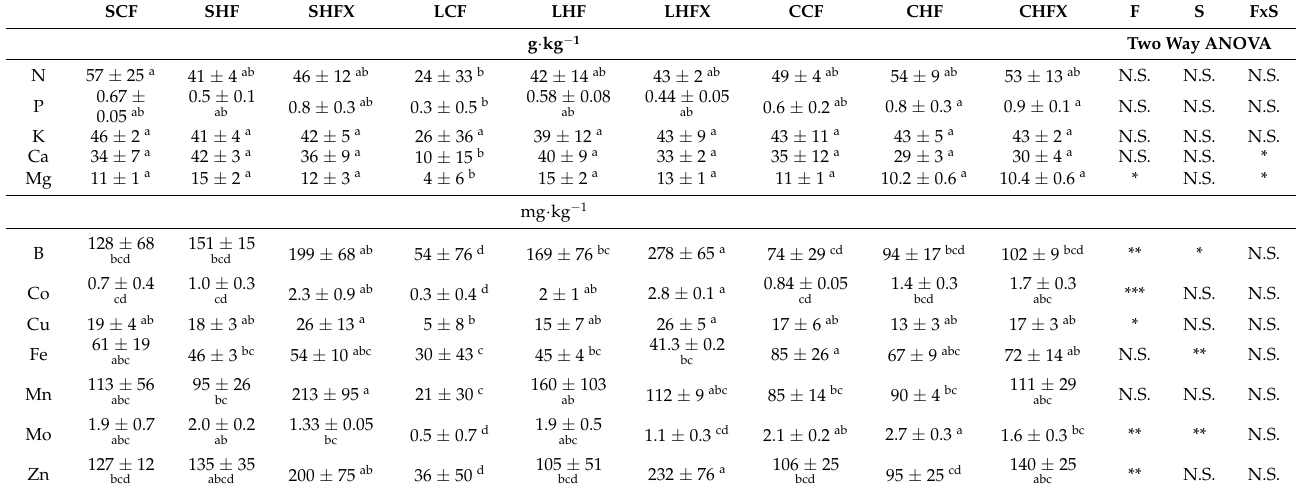
Table 5. Foliar macro and micronutrient analysis of Capsicum annum L. grown in the sandy loam (S), clay loam (L) and clay (C) soils using the nutrient solutions: conventional fertilization (CF), MCT ® fertilizers (HF) and MCT ® fertilizers plus TX (HFX). Data are presented as the mean ± standard deviation ( n = 3). Two-way ANOVA was performed to evaluate the effect of fertilization (F) and soil (S) and their interaction.